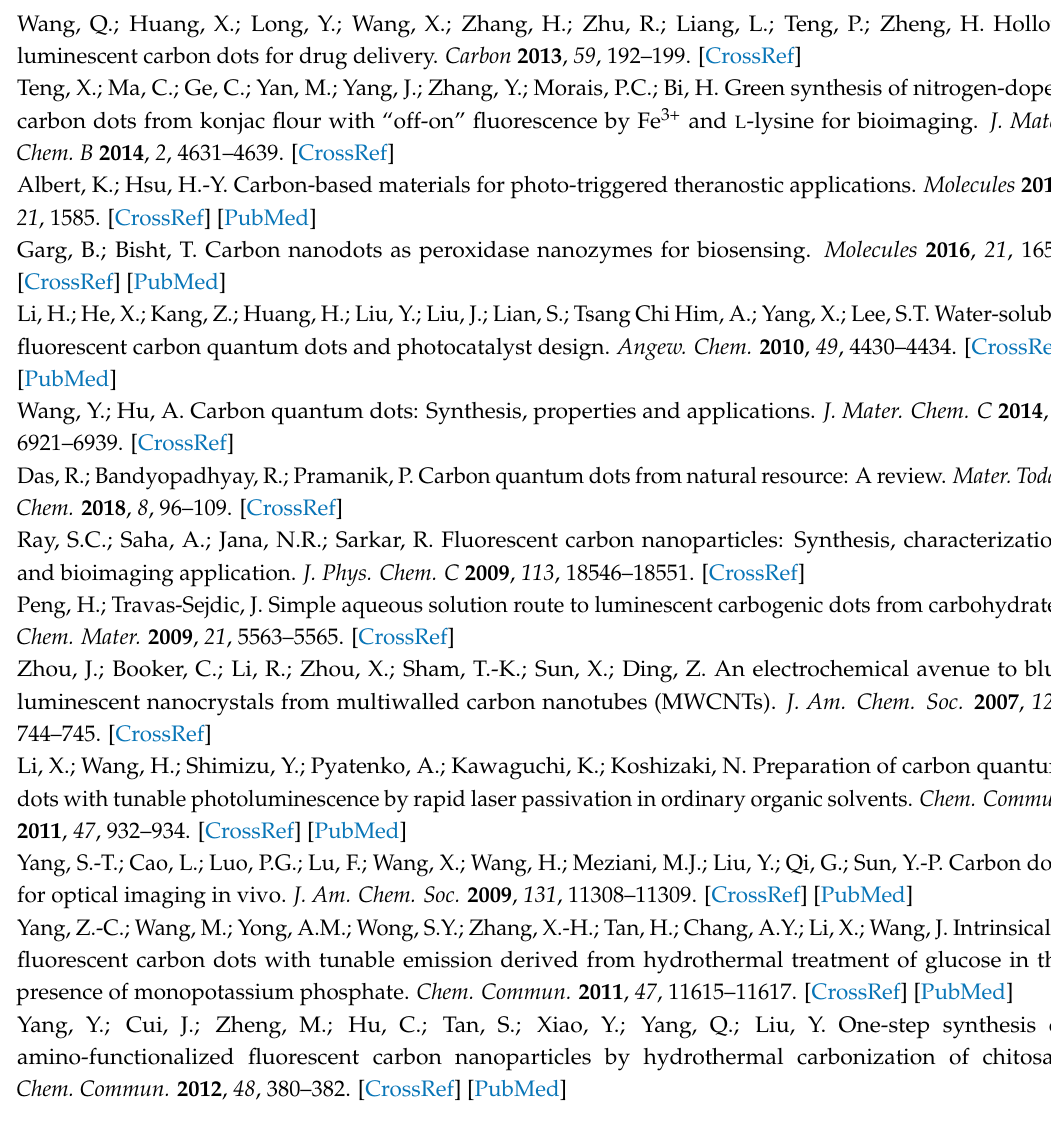
assay. Table S1. Representative experimental results of cyclic voltammograms for the DPPH • -gold electrode system reacted with three types of CNDs at different